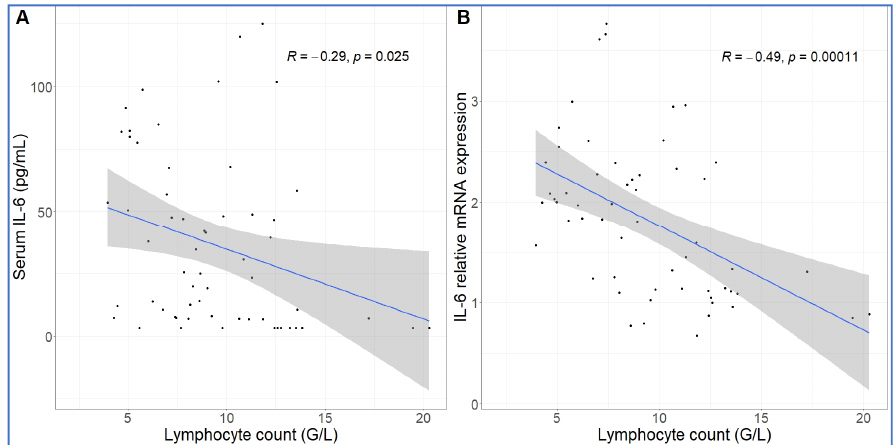
Figure 7. Correlation between IL-6 protein secretion and gene expression and absolute lymphocyte counts. The lymphopenia significantly correlated with increased IL-6 protein ( A ) and mRNA expression ( B ) over time. Linear regression.